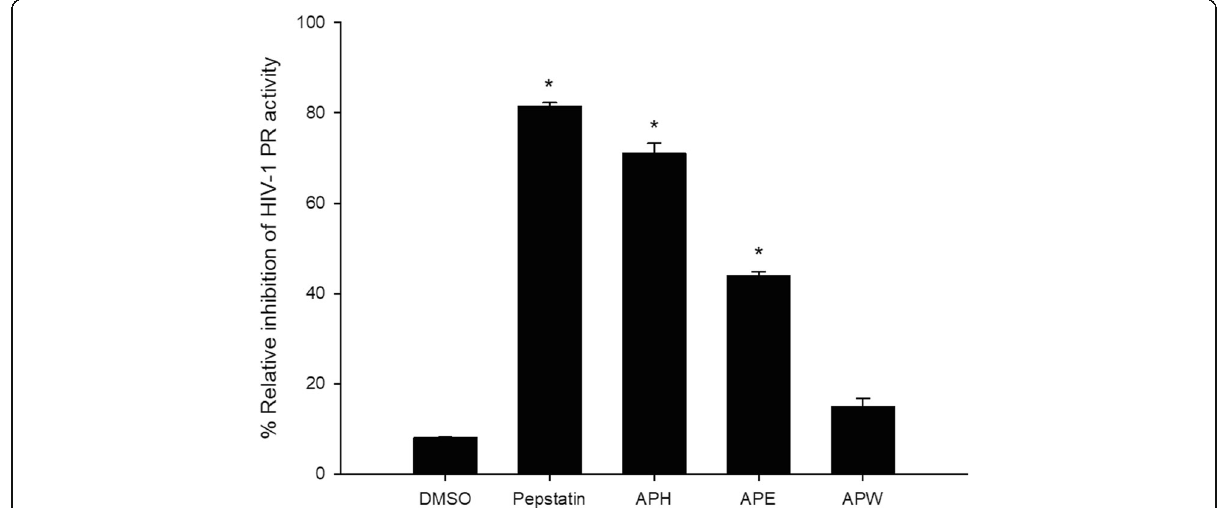
Fig. 1 Percentage of inhibitory on HIV-1 PR activity of DMSO (1.0%, v/v), pepstatin (1 mM) and crude AP extracts (1 mg/ml). The error bars indicate the standard error of the means. * p < 0.05 compared to vehicle control